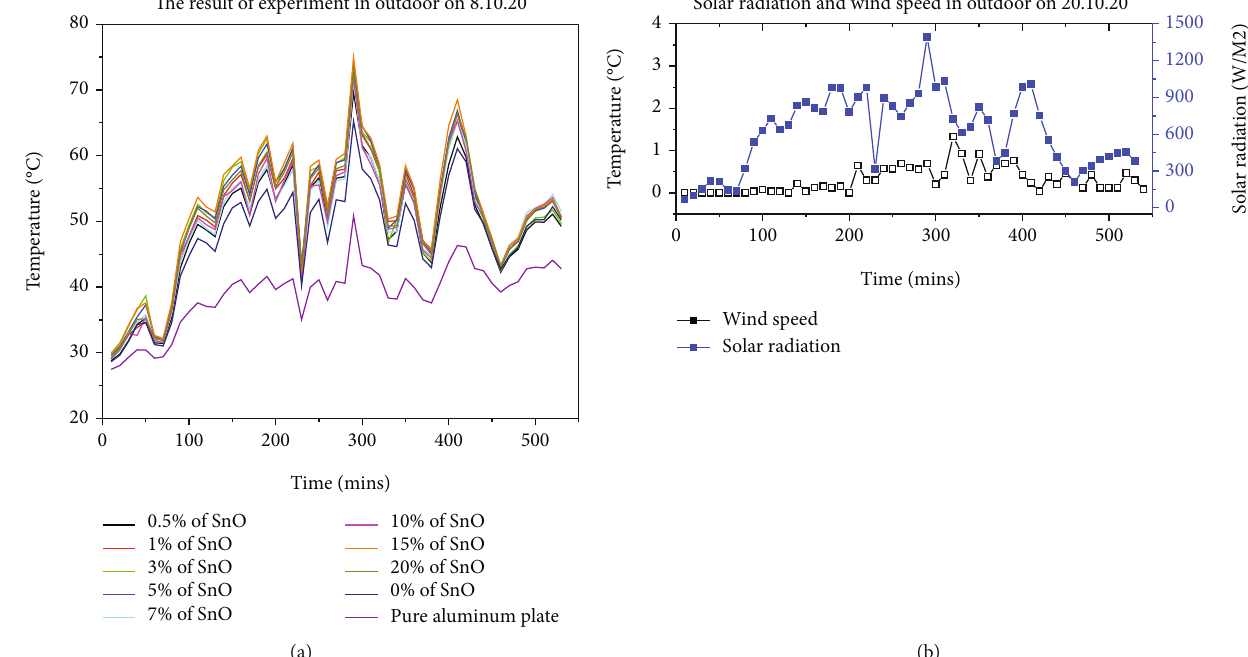
Figure 7: The various concentration e ff ects on the sample ’ s temperature in outdoor conditions was taken on